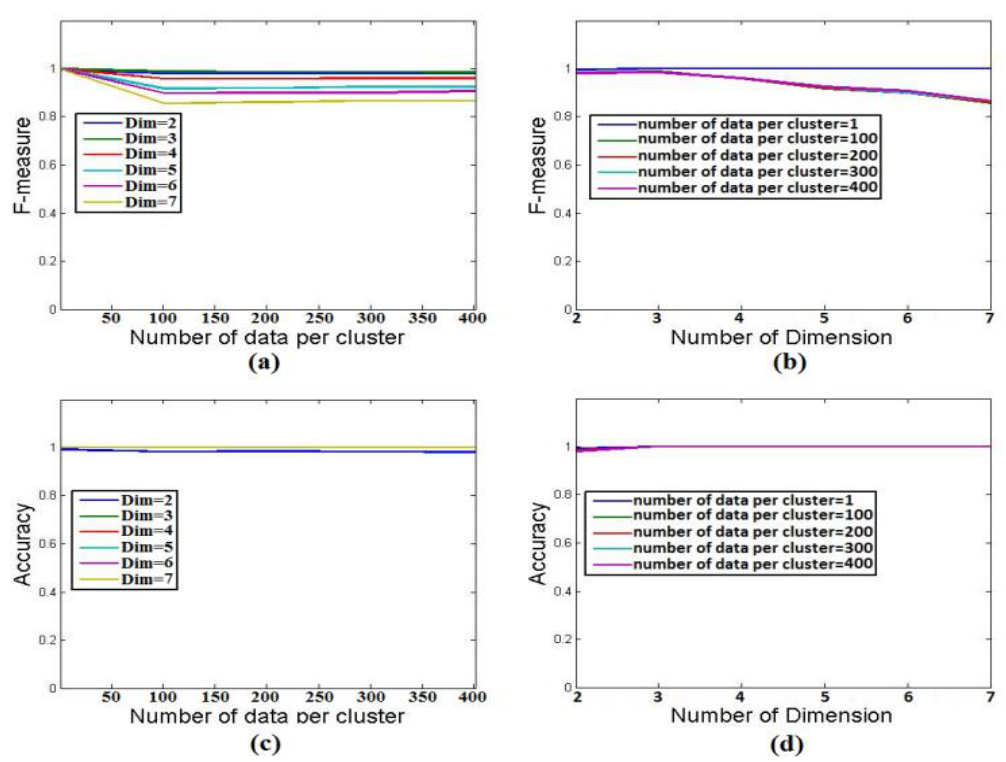
Figure 13. a) F-measure is almost constant when the number of data per clusters increases. Decreasing in F-measure as the number of dimensions increases is related to the generated